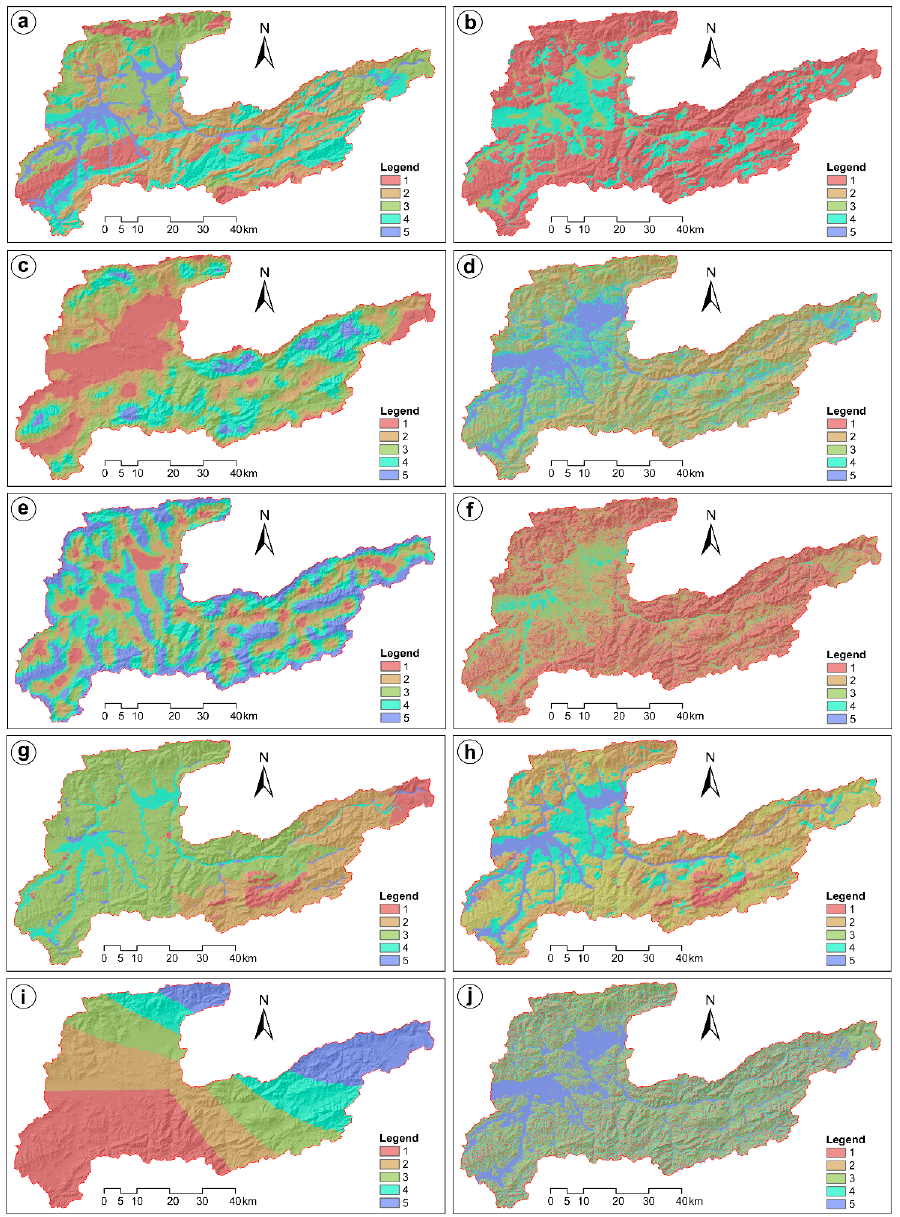
Figure 4. Spatial distribution of rating values for the thematic map layers representing ten main criteria used in the generation of groundwater potential zones (GWPZs): ( a ) lithology, ( b ) land-use classes, ( c ) lineament density, ( d ) slope, ( e ) drainage density, ( f ) topographic wetness index, ( g ) soil type, ( h ) soil thickness, ( i ) rainfall, ( j ) geomorphology. The rating values given under the legends represent the following: 1 = very low potential, 2 = low potential, 3 = moderate potential, 4 = high potential, 5 = very high potential.